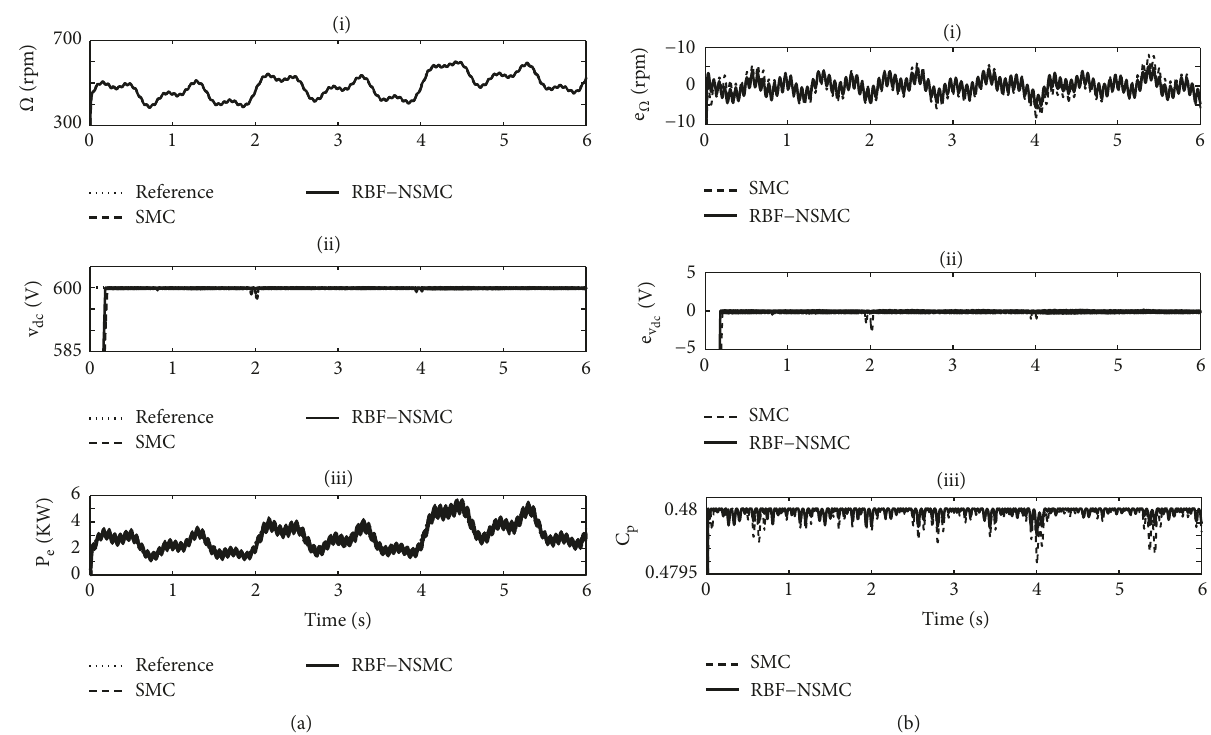
Figure 6: Control system response to wind speed fluctuations with nominal values of parameters. (a) (i) Generatorspeed, (ii) dc-link voltage, and (iii) generator electrical power. (b) (i) Generator speed error, (ii) dc-link voltage error, and (iii) power